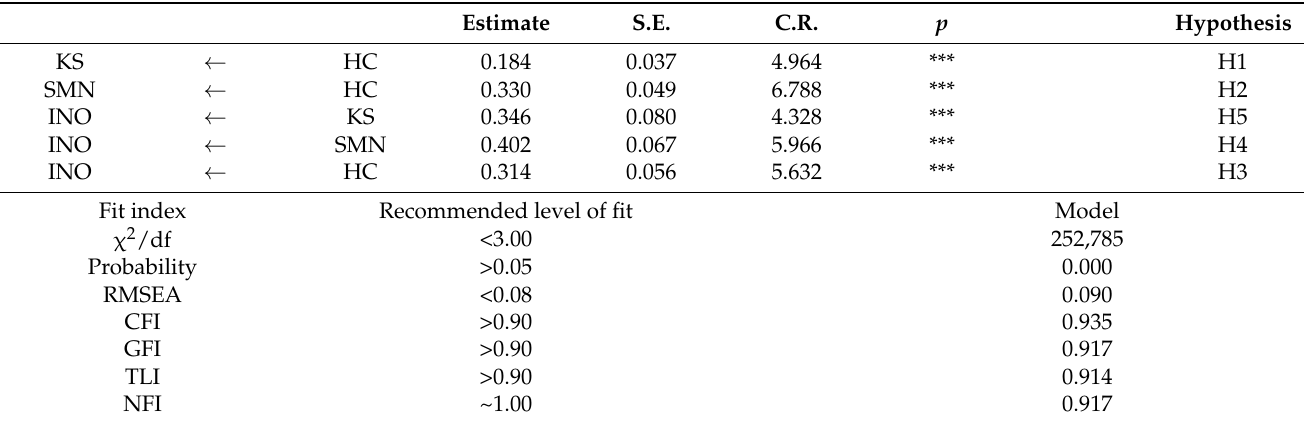
Figure 2. Full Structural Model. Table 4. Path Analysis Test